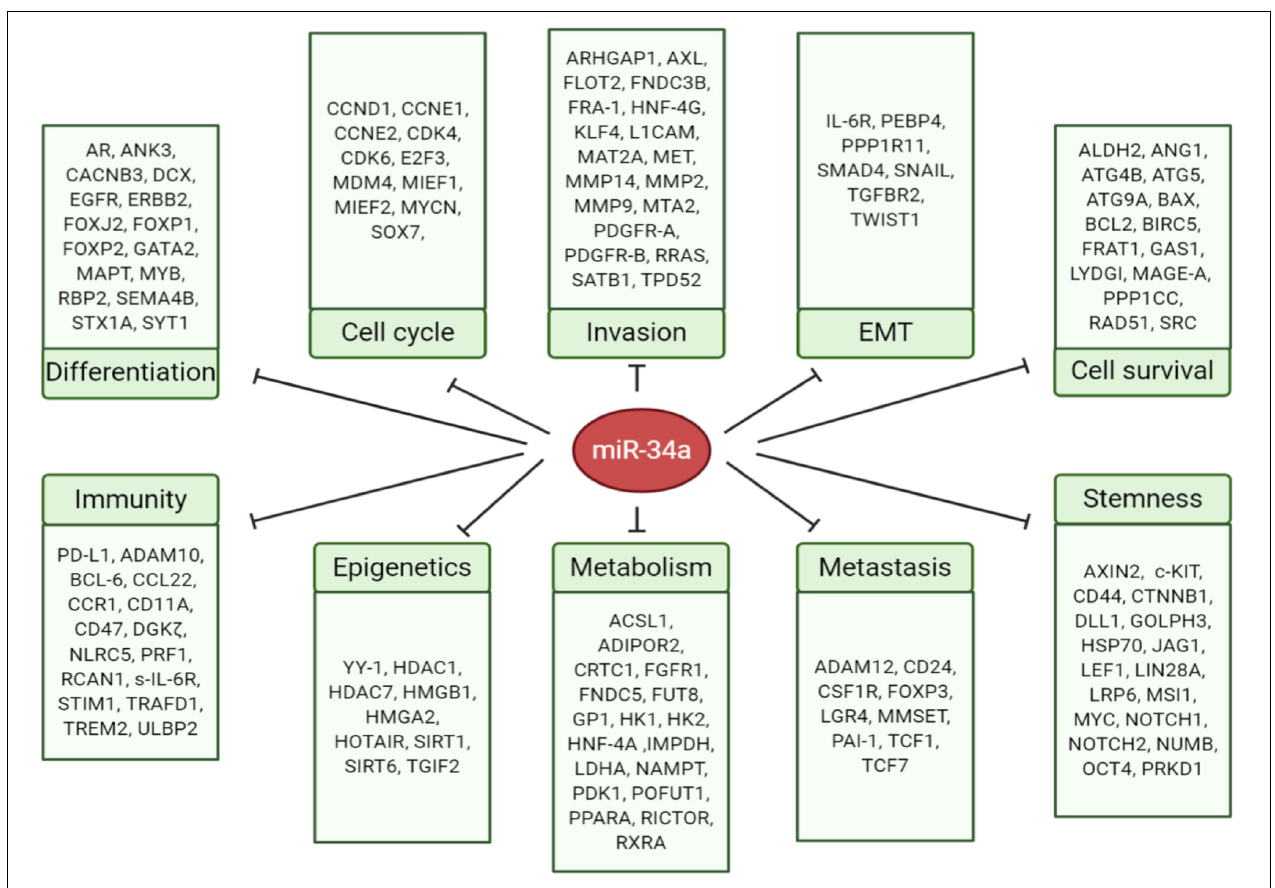
FIGURE 2 | MicroRNA-34 regulates cancer-relevant cellular processes by targeting key factors. The direct targets of miR-34a are grouped into 10 cellular processes according to their main